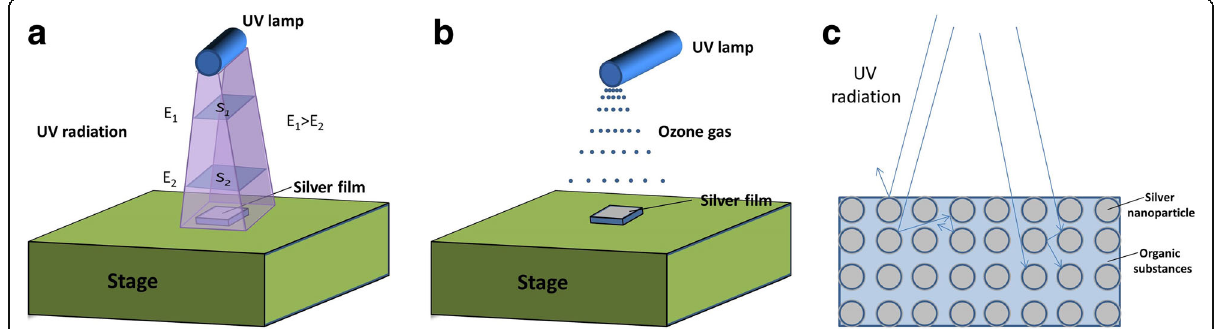
Fig. 1 The schematic diagrams of UV curing method: ( a ) the intensity of UV irradiation at different distances; ( b ) the distribution of the ozone gas generated by UV irradiation; ( c ) the propagation of UV irradiation when silver film is being cured